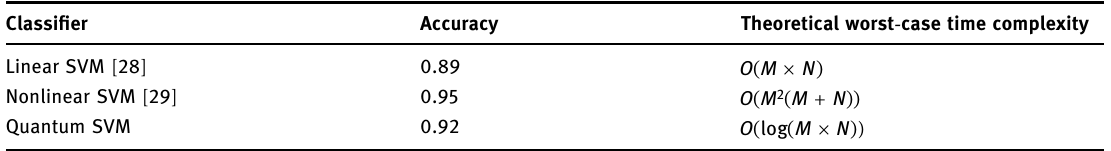
Table 5: Performance tradeo ff for the three SVM variants Classi fi er